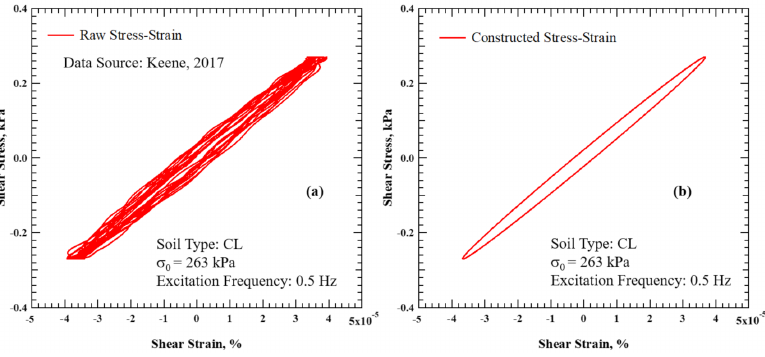
Figure 5. ( a ) Raw stress-strain loops vs. ( b ) constructed stress-strain loops. As presented in Table 1, the last three points of λ min calculated with the phased-based method are more consistent with all values around 3.6%. However, the first λ min is still higher than the other three values due to the poor quality of the signal at extremely small strains (less than 3.4 × 10 − 5 % in this case). This method is insufficient to eliminate the effect of ambient noise on the measurements, especially at strains of around 10 − 5 %. Table 1. Comparison of λ min from the two methods. λ min , ID. Shear Strain, %